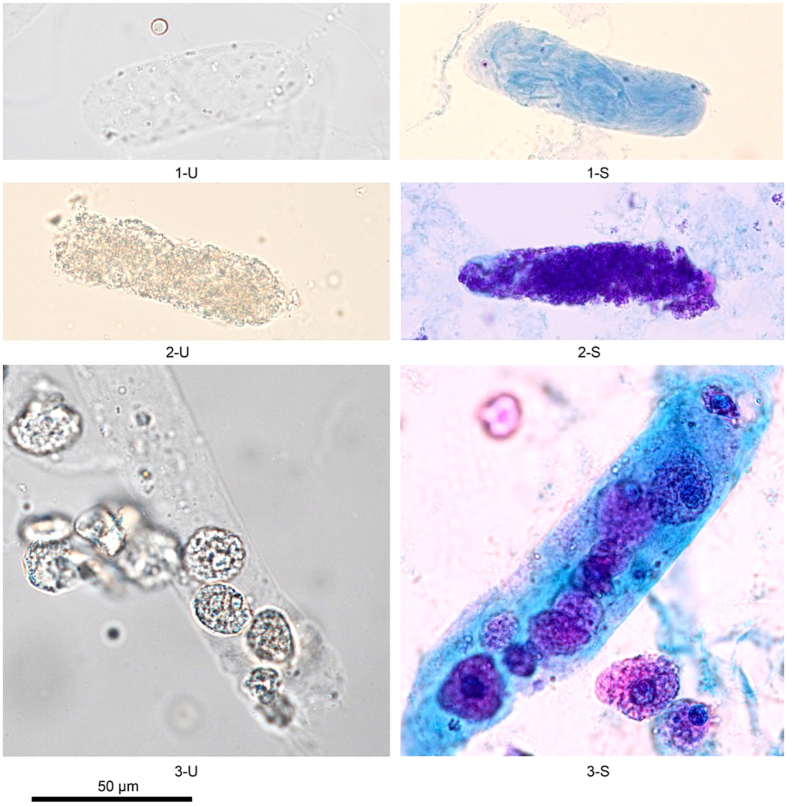
Casts, 400×.U, unstained; S, Sternheimer stain. (1-U) Hyaline cast: the matrix of the hyaline cast is transparent with two rounded ends. (1-S) After staining, the contrast increases, and the matrix of the hyaline cast is light blue. (2-U) Granular cast: the colourless matrix has many granules. (2-S) After staining, the contrast increases, the matrix of the cast is light blue, and the granules are dense purple. (3-U) Renal tubular epithelial (RTE) cell cast: the colourless matrix of the cast has four renal tubular epithelial cells. (3-S) After staining, the contrast increases, and the matrix of the RTE cell cast is light blue. The cytoplasm of an RTE cell is pink-red, and the nucleus of an RTE cell is cyan blue.